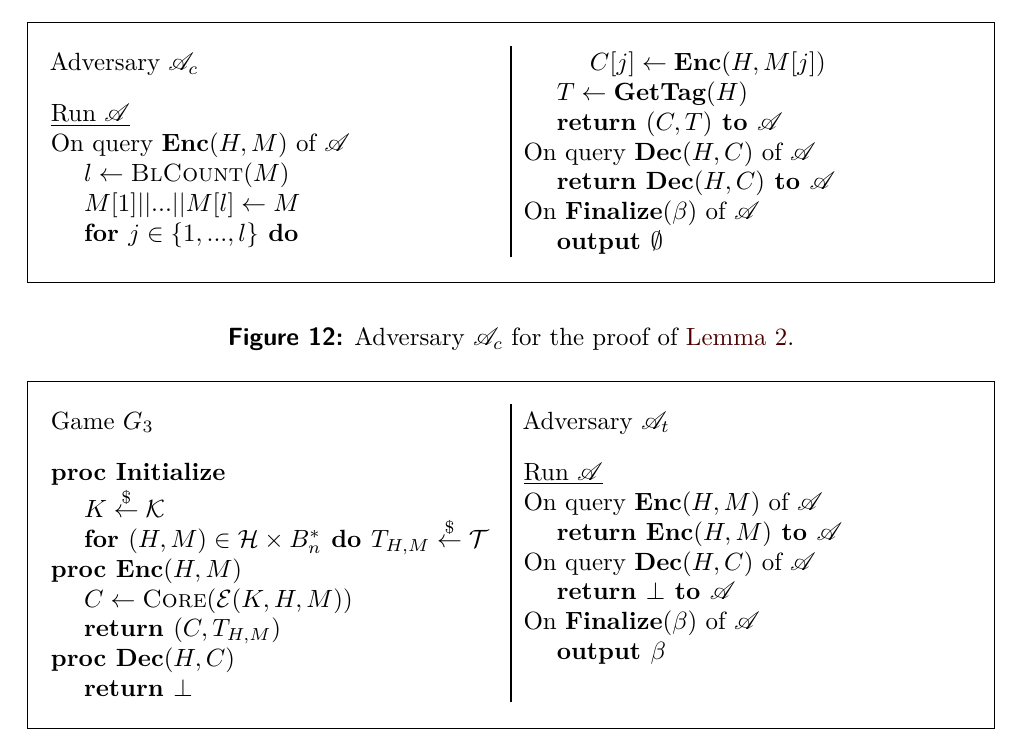
Figure 13: Game G 3 (left) and adversary A t (right) for the proof of Lemma